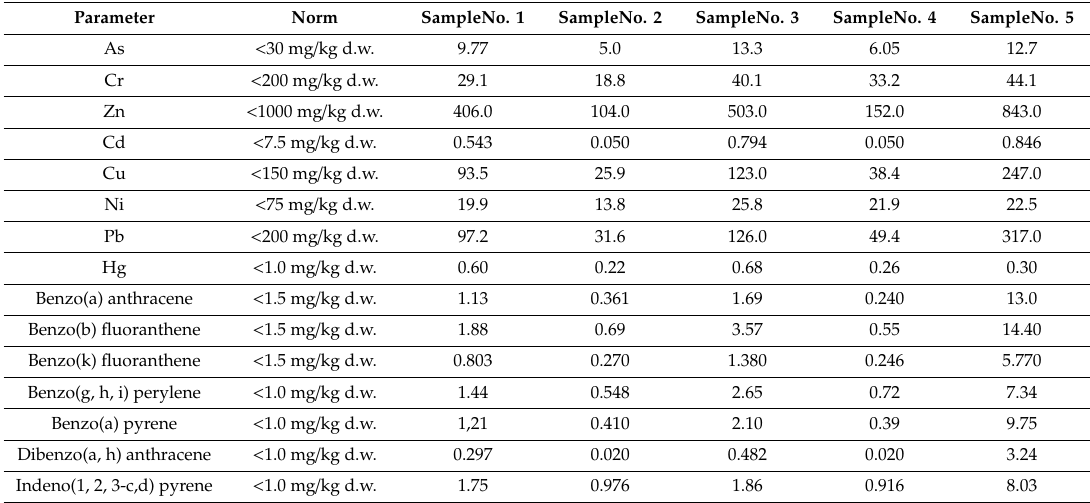
Table 3. Organic pollutants and heavy metal contents in bottom sediment of Karczemne Lake. Parameter Norm SampleNo. 1 SampleNo. 2 SampleNo. 3 SampleNo. 4 SampleNo. 5 As < 30 mg / kg d.w. Cr < 200 mg / kg